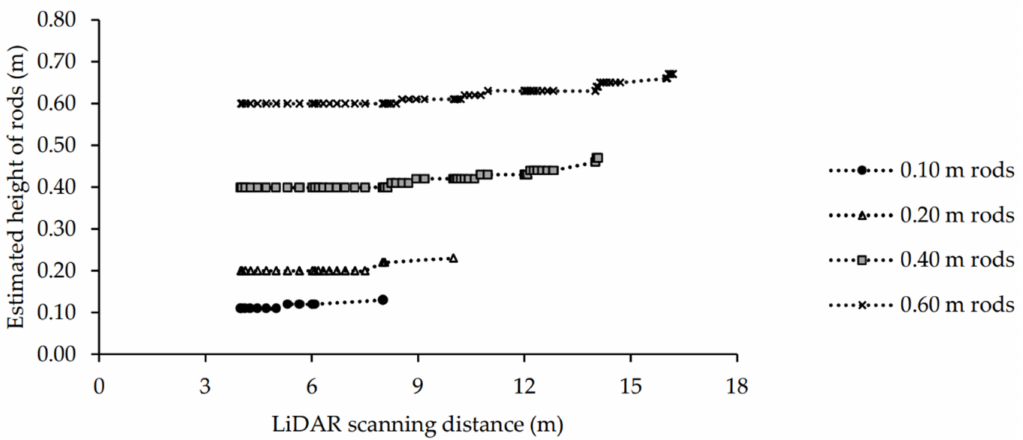
Figure 5. Comparison of the actual height (0.10, 0.20, 0.40 and 0.60 m) and LiDAR-estimated heights at different scanning distances of 4 to 16 m for the line of